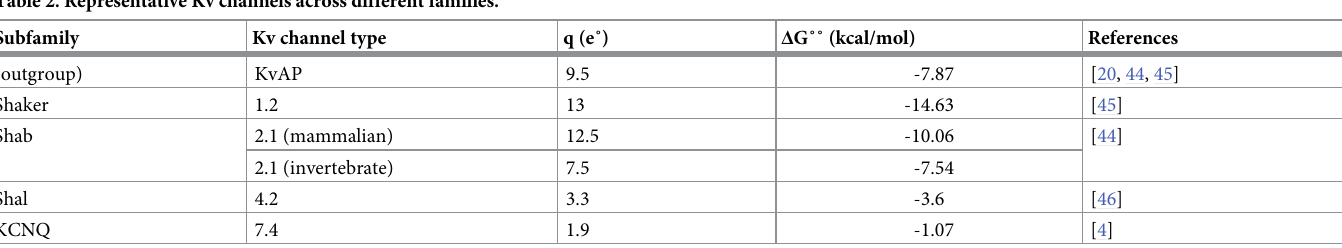
Table 2. Representative Kv channels across different families. Subfamily